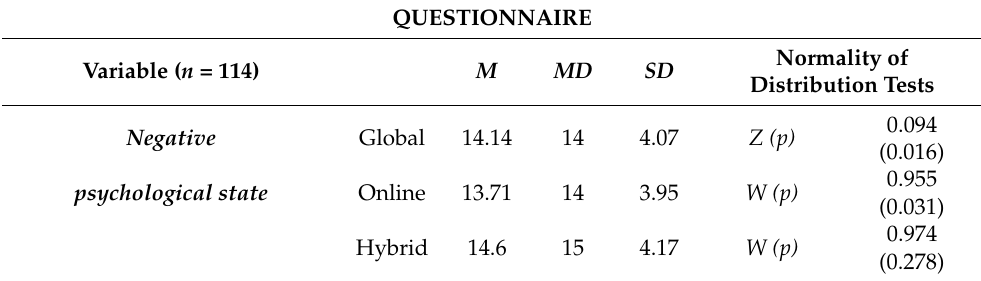
Table 2. Descriptive statistics for factors in the coping styles variable and non-clinical symptoms of depressed mood or